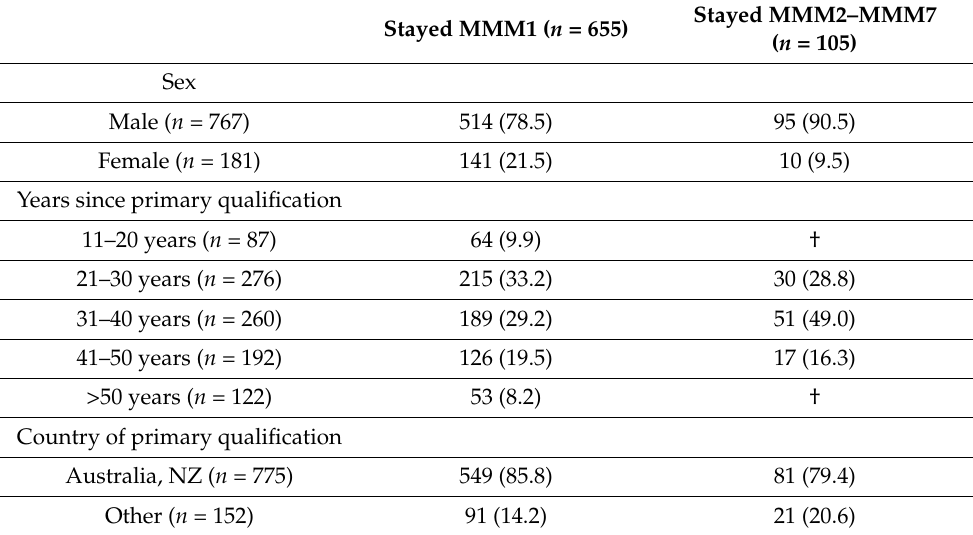
Table 3. Characteristics of ophthalmologists by geographic mobility group, 2014 to